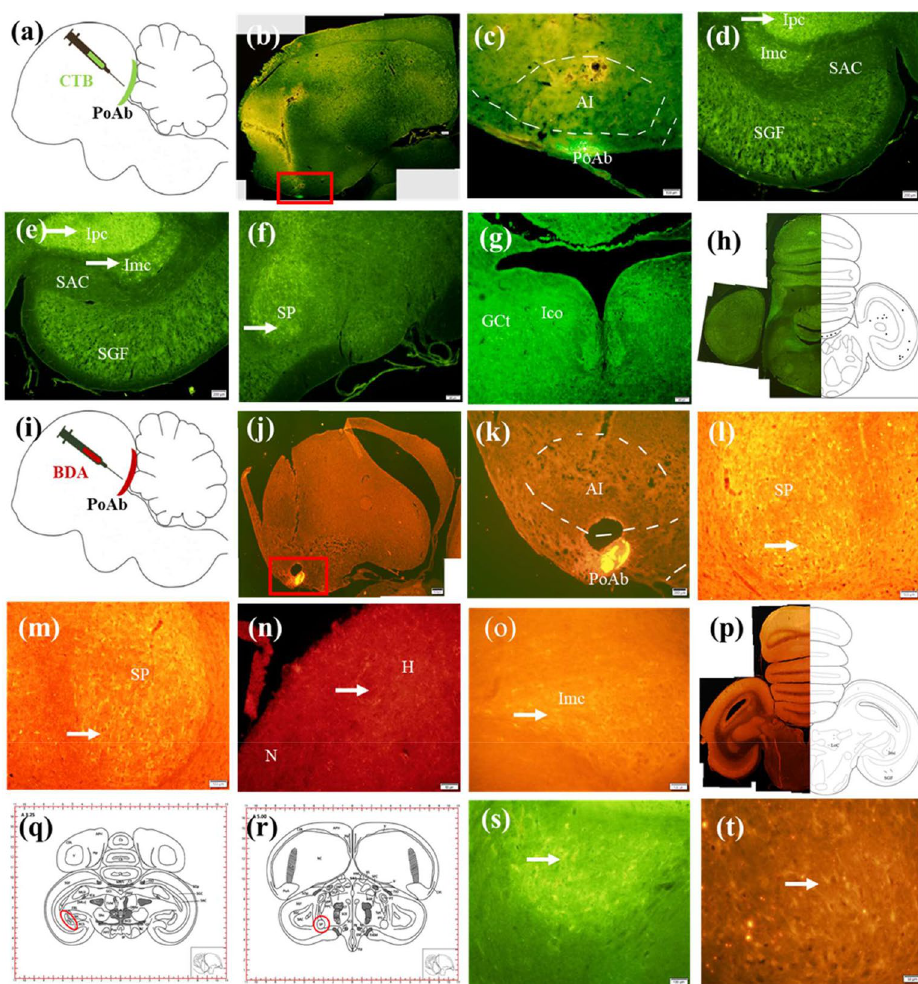
Figure 1. Fiber connections of PoAb. Schematic sagittal view of in vivo CTB injections ( a ) and BDA injections ( i ) into PoAb. ( b ) Injection site of CTB in the PoAb at A 6.25. ( c ) Enlargement of the box in ( b ). ( d ) Ipsilateral CTB-labeled neurons in Imc at A 3.5. ( e ) Contralateral CTB-labeled neurons in Imc at A 3.5. ( f ) Ipsilateral CTB-labeled neurons in SP at A 5.0. ( g ) Bilateral CTB-labeled neurons in GCt and Ico at A 3.25. ( h ) Schematic of CTB-labeled at A 1.25. ( j ) Injection site of BDA in the PoAb at A 5.75. ( k ) Enlargement of the box in ( j ). ( l ) Ipsilateral labeled fibers in SP at A 5.25. ( m ) Contralateral labeled fibers in SP at A 5.25. ( n ) Ipsilateral labeled fibers in N and H at A 13.0. ( o ) Contralateral labeled fibers in Imc at A 4.0. ( p ) Schematic of BDA-labeled at A 2.75. ( q ) Coronal whole brain map at A 3.25 based on Nissl staining results. ( r ) Coronal whole brain map at A 5.0 based on Nissl staining results. ( s ) Enlargement of the CTB-labeled neurons in Imc at A 3.25 in ( q ). ( t ) Enlargement of the BDA-labeled fibers in SP at A 5.25 in ( r ). ( b – h ) and ( j – t ) were the coronal slice of pigeon brain. Arrows indicate the labeled fibers and terminals, or the neurons. Scale bars = 200 µm in ( b ), ( d ), ( e ), ( f ), ( g ), ( h ), ( j ), ( k ), ( p ); 100 µm in ( c ), ( l ), ( m ), ( o ), (s ) ; 50 µm in ( n ), ( t ). BaS basorostral pallial nucleus; BDA biotinylated dextran amine; CTB cholera toxin subunit B; GCt substantia grisea centralis; H hyperpallium; HA hyperpallium apicale; Ico nucleus intercollicularis; Imc nucleus isthmi, pars magnocellularis; Ipc nucleus isthmi, pars parvocellularis; N nidopallium; nIV nucleus nervi trochlearis; PoAb basal division of posterior pallial amygdala; SAC stratum album central; SGF stratum griseum et fibrosum superficial; SP nucleus